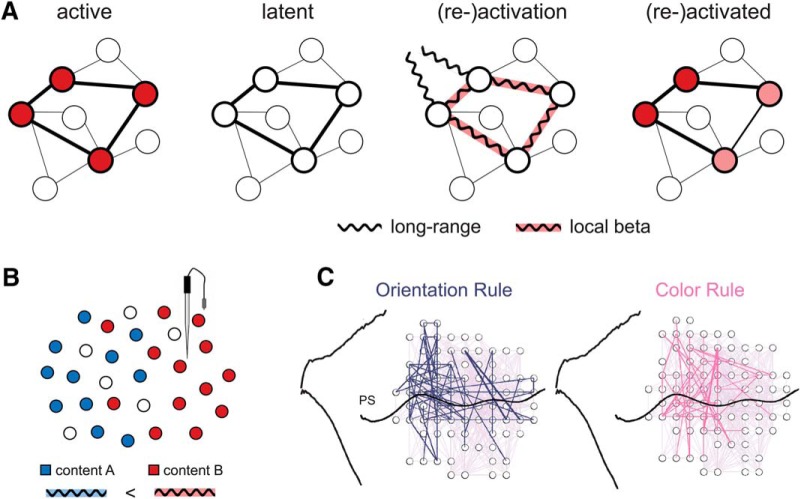
A framework for content-specific beta activity. A, Content-specific beta-synchronization as endogenously driven transition from latent to active cortical representation. Left, Active cortical representations (e.g., of currently perceived, task-relevant information) are characterized by spiking activity (symbolized in red) in content-specific neuronal ensembles. Second from left, In the absence of perceptual input and/or attentional prioritization, information can be retained in latent memory representations, without spiking activity in the content-specific ensemble, e.g., in patterns of synaptic weights. Second from right, Endogenously driven (re)activation of a content-coding ensemble is characterized by a brief period of beta-synchronization, involving both local and long-range (top-down) interactions (see text for details). Right, (Re)activated content representations may again be characterized by spiking ensemble activity, similar (but not necessarily exactly identical) to representations of just perceived information (compare with left). B, Local beta activity appears content specific when population-level recordings register the synchronization of individual subpopulations (symbolized in blue and red) with differential sensitivity (e.g., red > blue, by spatial proximity to recording site). C, Transient network-level beta coherence in monkey PFC during application of different task rules (Fig. 2F, dashed rectangle). Adapted with permission from Buschman et al. (2012). Reprinted with permission from Elsevier.